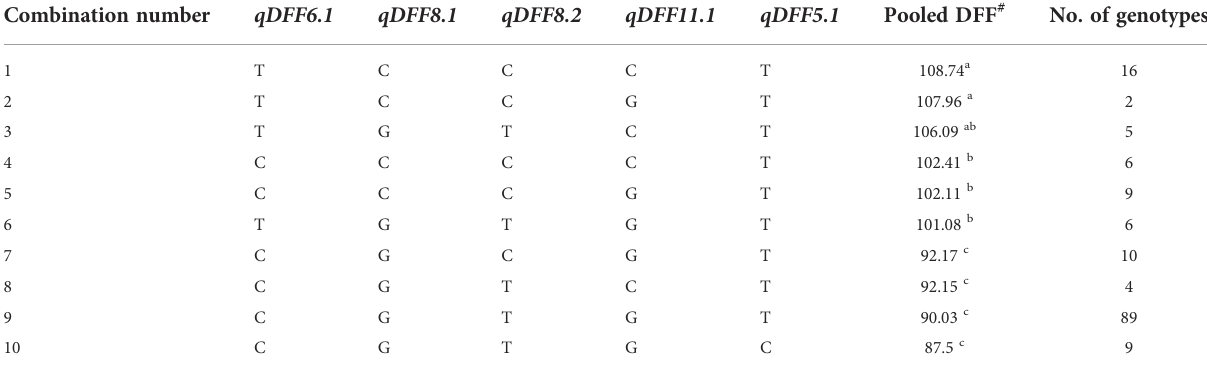
TABLE 6 List of all available homozygous allelic combinations of selected QTNs for DFF. Combination number